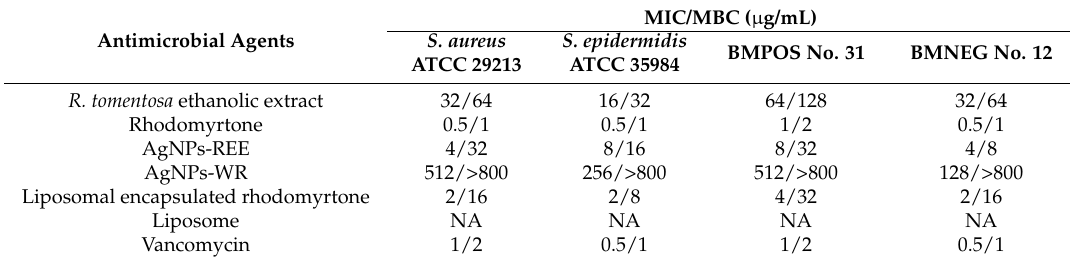
Table 1. Minimum inhibitory concentrations (MIC) and minimum bactericidal concentrations (MBC) of antimicrobial agents against staphylococcal